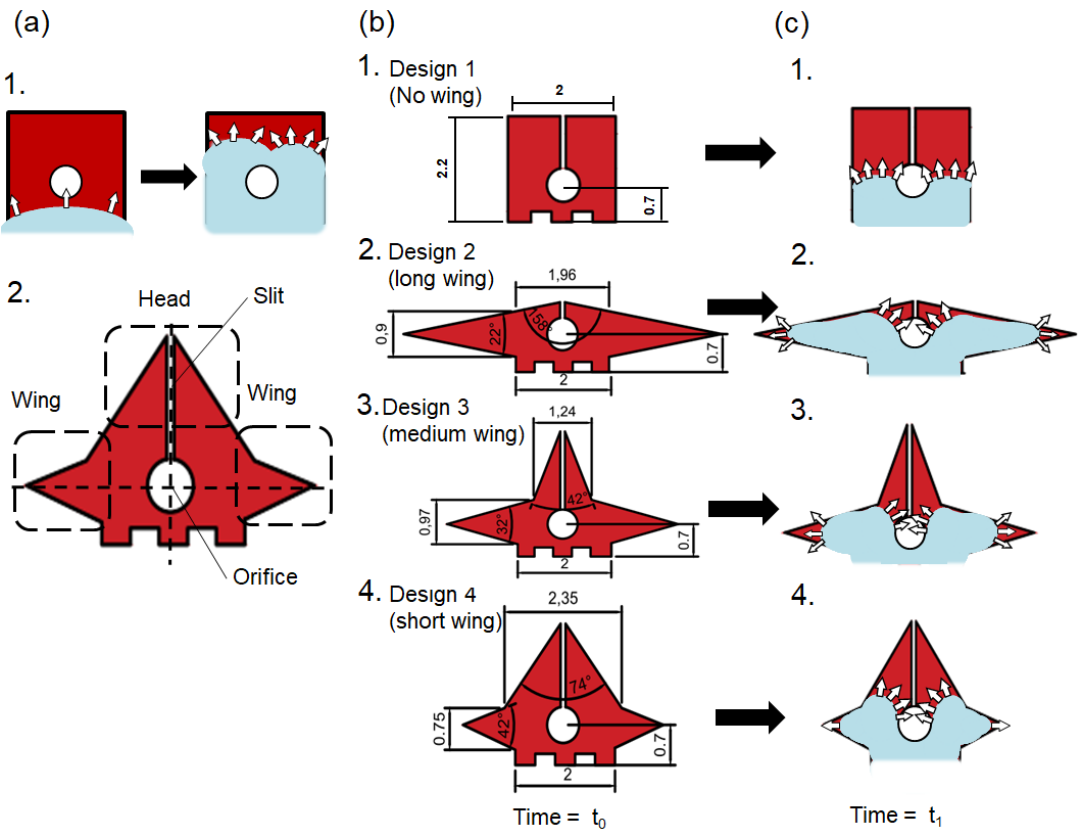
Figure 3. ( a-1 ) The droplet spreads around the terminal electrode (square shape). ( a-2 ) Geometrical definition of the terminal electrode. ( b ) The four designs of the terminal electrodes used in our study. ( c ) EWOD force directions at the droplet meniscus from the initial to the suspended stage on the terminal